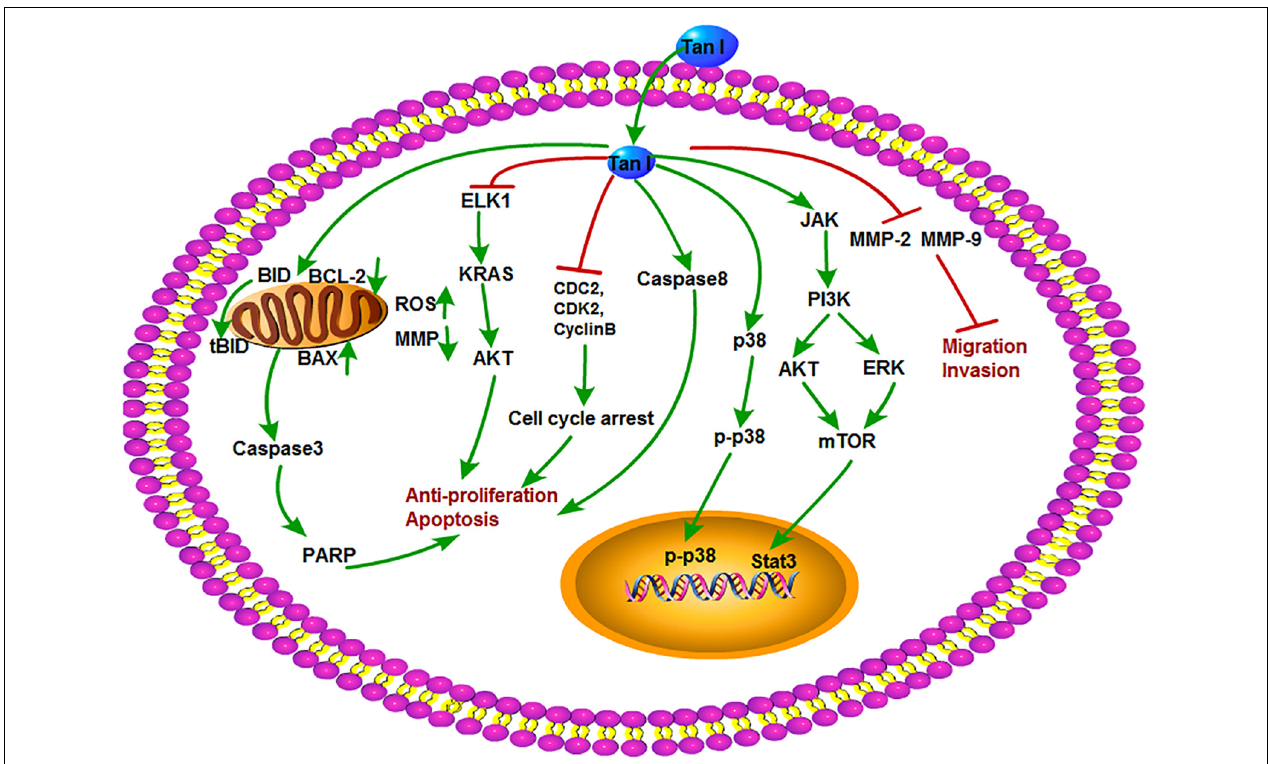
FIGURE 5 | The antitumor mechanism of Tan I. Tanshinone I inhibits proliferation and induces apoptosis of cancer cells by regulating cell cycle and mitochondrial pathway and inhibits cancer cell invasion and migration by inhibiting MMP-2 and MMP-9 signals. The arrow represents the promotion effect, and the T area represents the inhibition